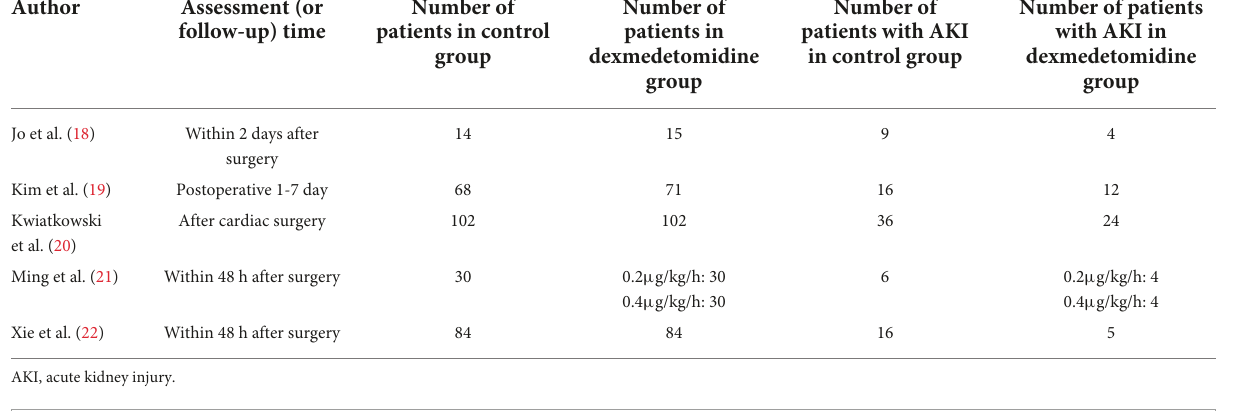
TABLE 2 Follow-up time and number of patients with AKI under different intervention methods.